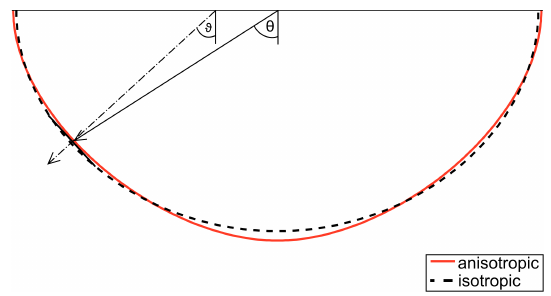
Figure 1. Wavefront of a P wave travelling in isotropic ice fabric (dashed line) and in a vertical single maximum (VSM) fabric (red line), i.e. a vertical transversely isotropic (VTI) medium. The solid arrow shows the group velocity with group angle θ , the dashed ar- row the phase velocity with phase angle ϑ for the anisotropic